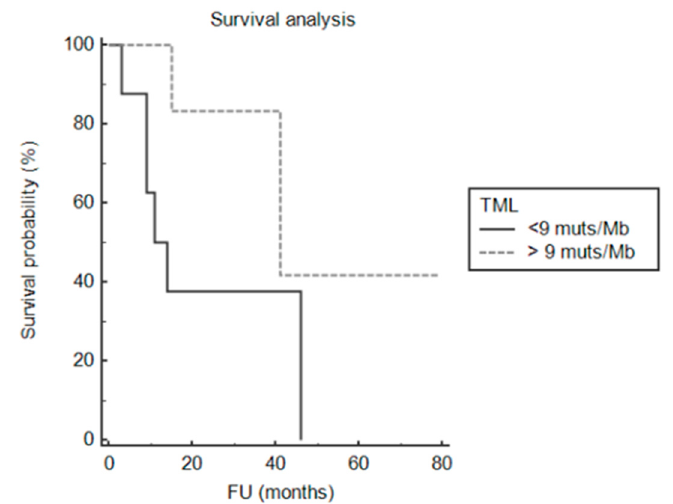
Figure 6. Impact of tumour mutational load on clinical outcome. Overall survival analysis showing that TML > 200 mutations/Mb was associated with better prognosis in IDH wild- type GBMs ( p -value = 0.036).